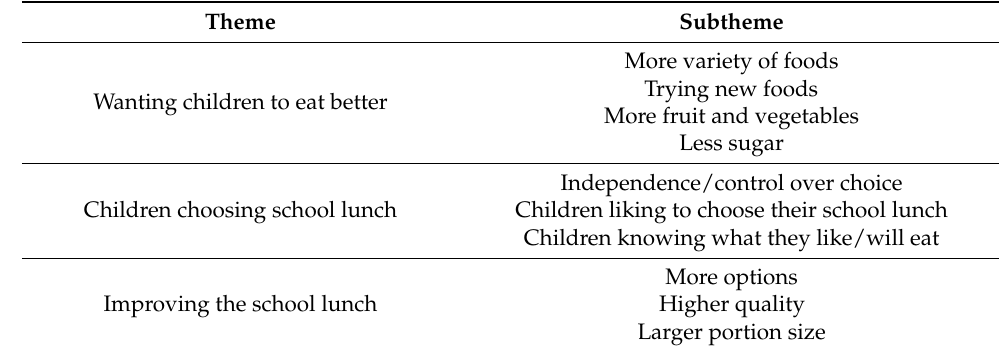
Table 3. Emerging themes and subthemes from analysis of parents’ comments.